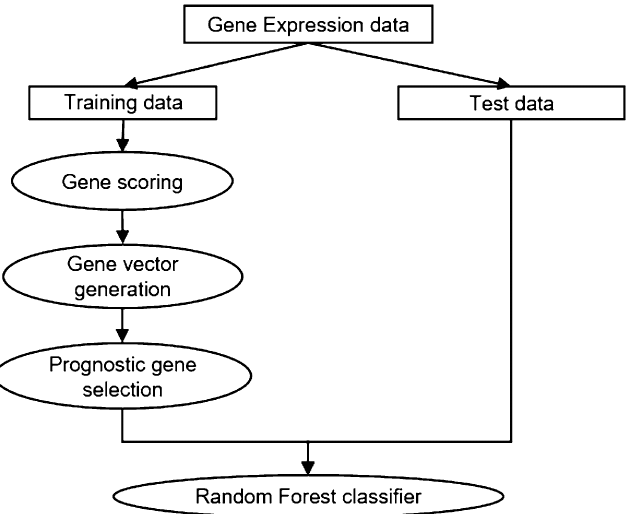
Figure 1. Overview of proposed model. The proposed model has three steps: (1) measuring gene scores; (2) generating gene vectors; and (3) extracting prognostic